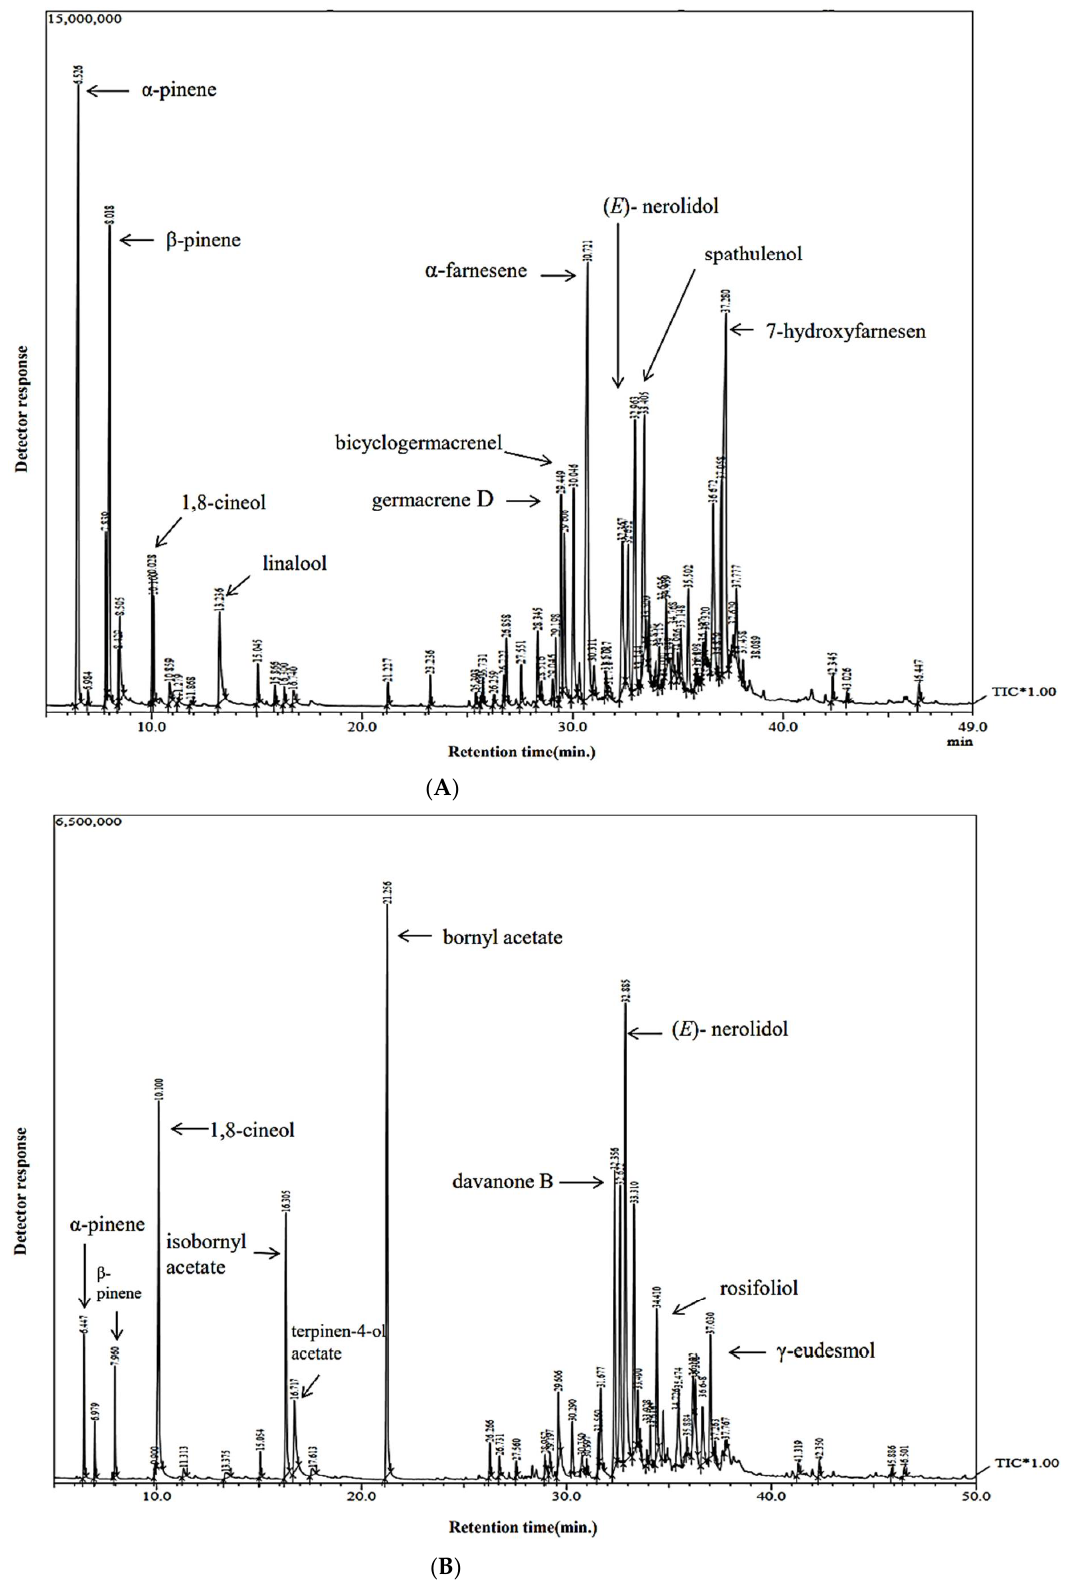
Figure 1. ( A ) Ion-chromatogram of HCCAO. ( B ) Ion-chromatogram of HCCRO. Relating to the chemical composition of essential oil fractions.